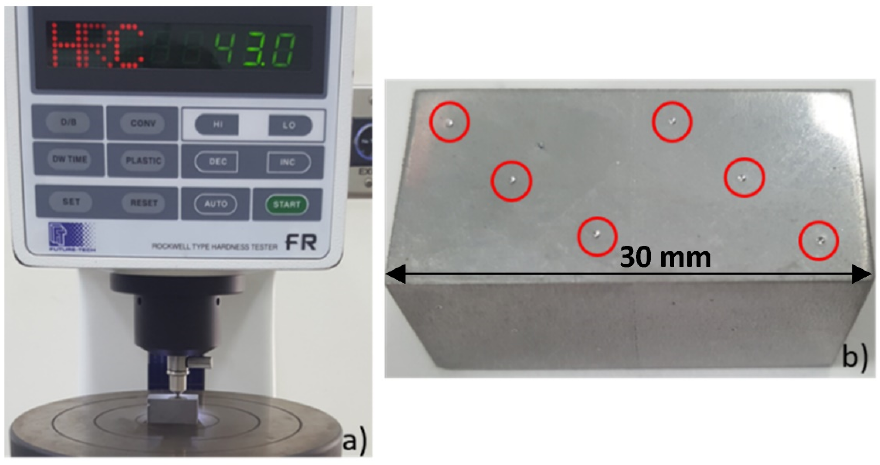
Figure 6. ( a ) Rockwell Type Hardness Tester; ( b ) illustration of measuring points.